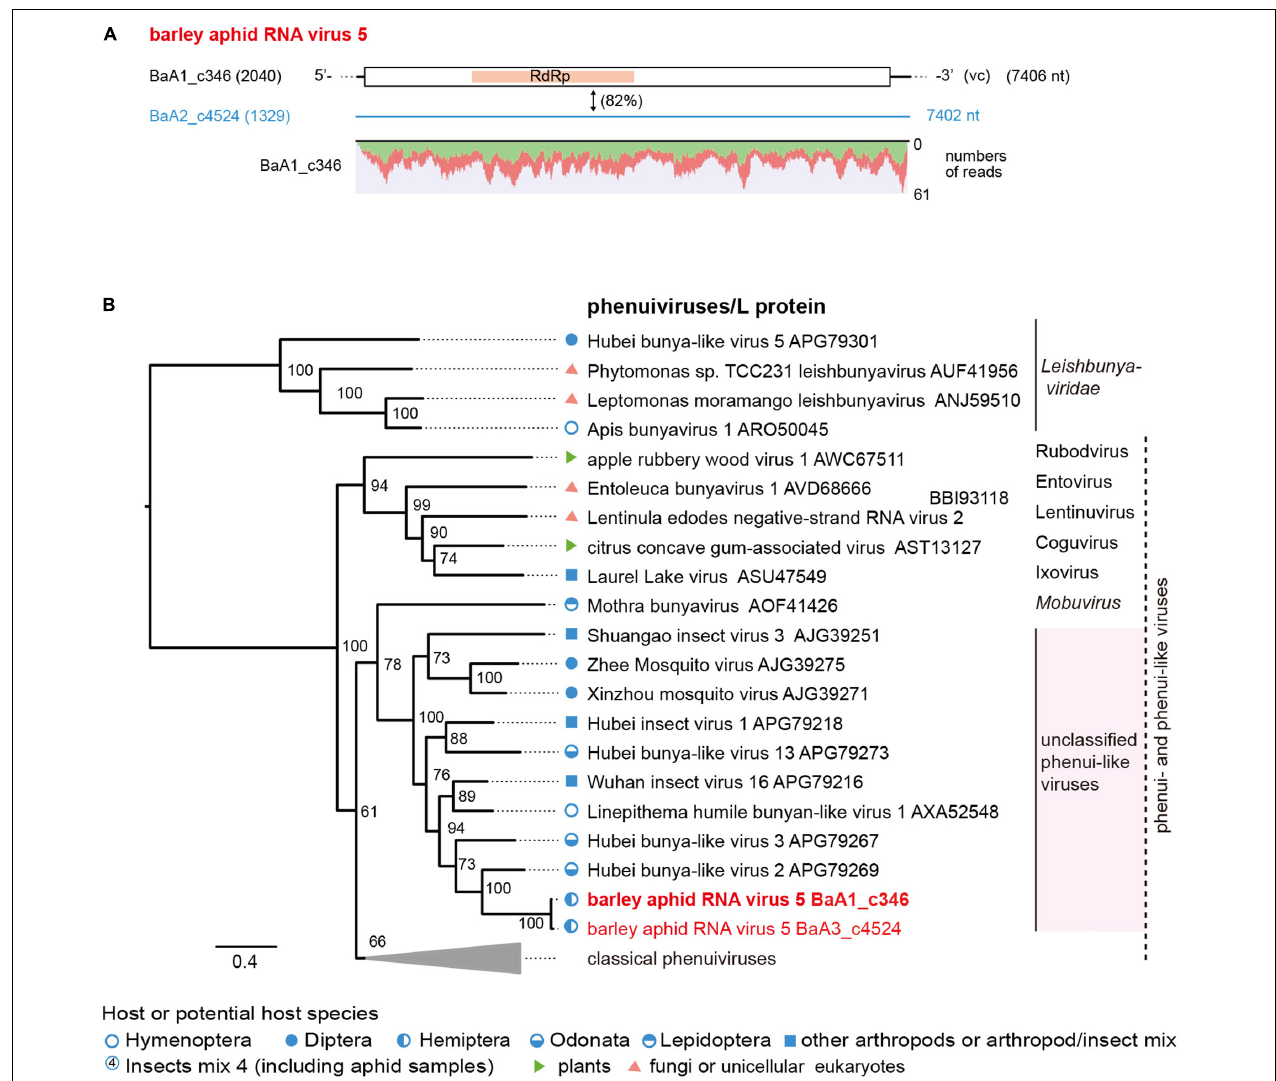
FIGURE 5 | The genome organization and phylogenetic relationships of phenui- and phenui-like viruses. (A) The genome structure of the putative L segments of a phenui-like virus (named barley aphid RNA virus 5, BARV-5) identified from Rhopalosiphum padi , R. maidis , and Sitobion avenae or R. maidis transcriptomes. The conserved domain for viral L proteins is shown as a red highlight within the ORF (RNA-dependent RNA polymerase, RdRp). Virus-like contigs in this study are shown as a black bar or a blue line, together with their read numbers in parentheses, and the nucleotide sequence identity between two virus-like contigs is shown. Read depth coverage throughout the assembled virus contig is shown below the schematic structure of the viral genome. (B) Phylogenetic relationships of BARV-5 and other selected phenuiviruses (family Phenuiviridae ) and phenui-like viruses. The ML phylogenetic tree was constructed using a multiple amino acid sequence alignment of the L proteins or its candidate sequences. The selected members of the genera within the family Phenuiviridae are displayed as a collapsed triangle (see Supplementary Table S3 for the virus names in the collapsed triangle). Some members of family Leishbuniyaviridae were used as the outgroups. The scale bar represents amino acid distances. The numbers at the nodes are bootstrap values of >